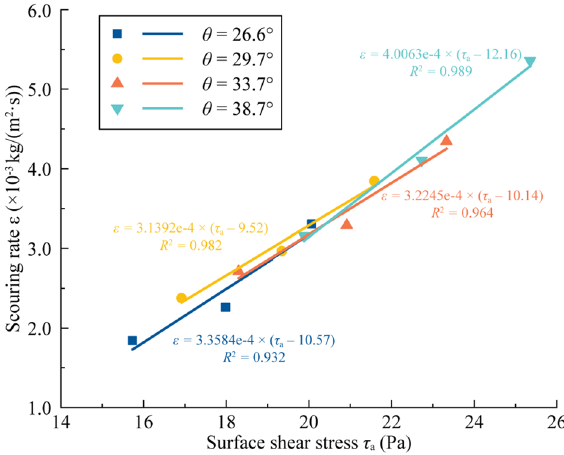
Figure 6. Linear relationship between the scouring rate and shear stress.